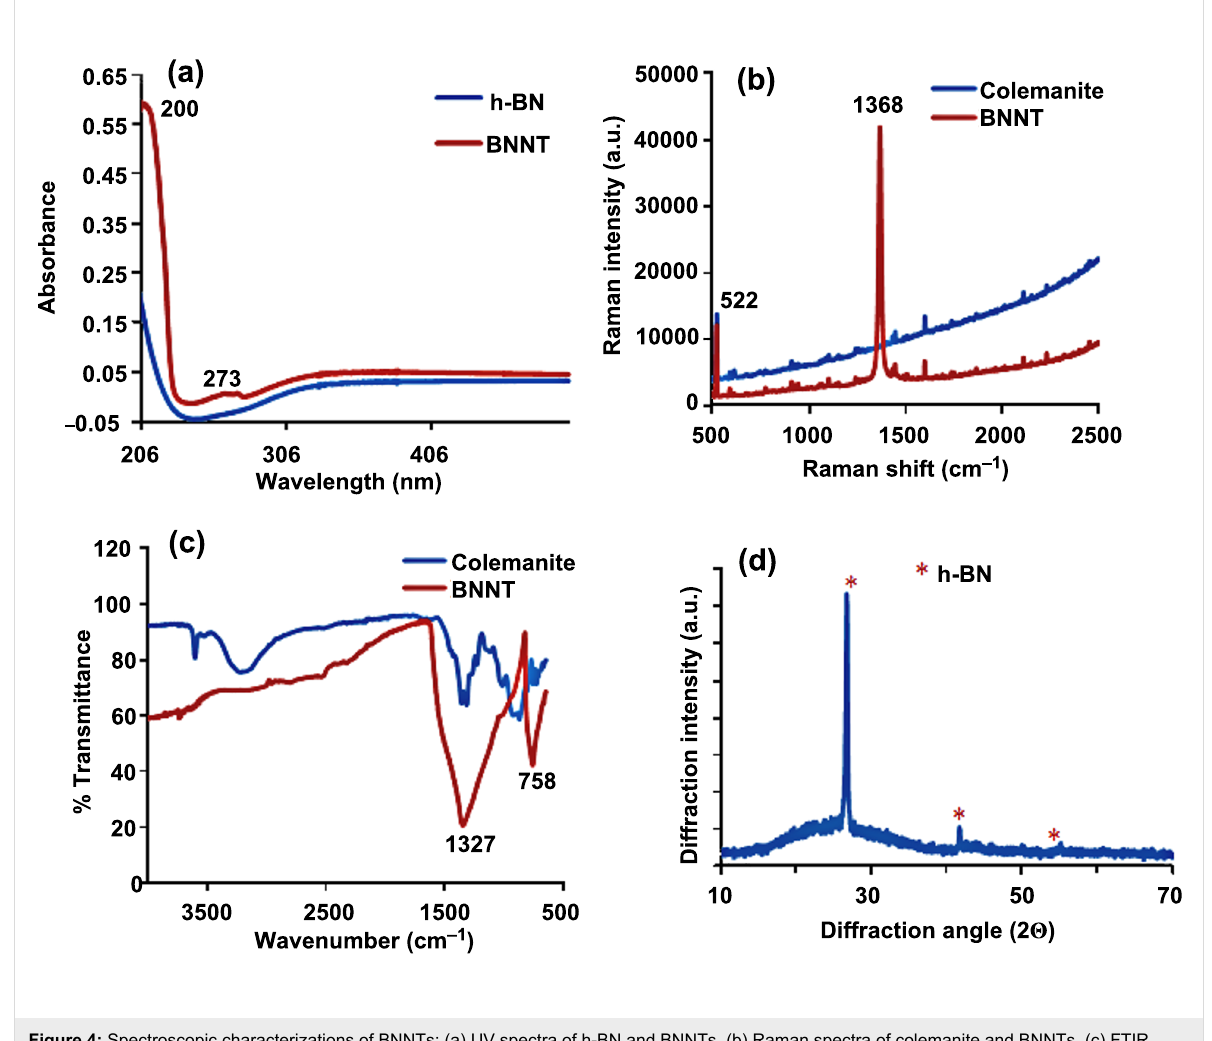
Figure 4: Spectroscopic characterizations of BNNTs: (a) UV spectra of h-BN and BNNTs, (b) Raman spectra of colemanite and BNNTs, (c) FTIR spectra of colemanite and BNNTs, (d) XRD pattern of BNNT.